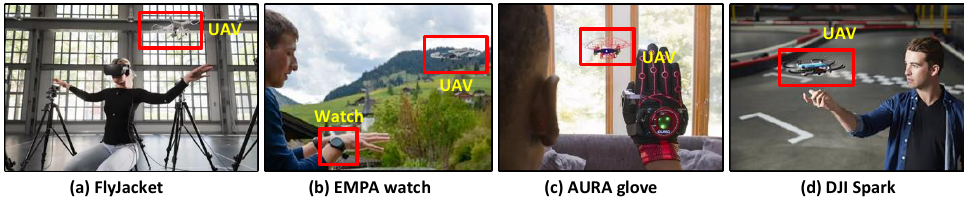
Figure 1. Recently developed system for controlling a UAV in different ways.